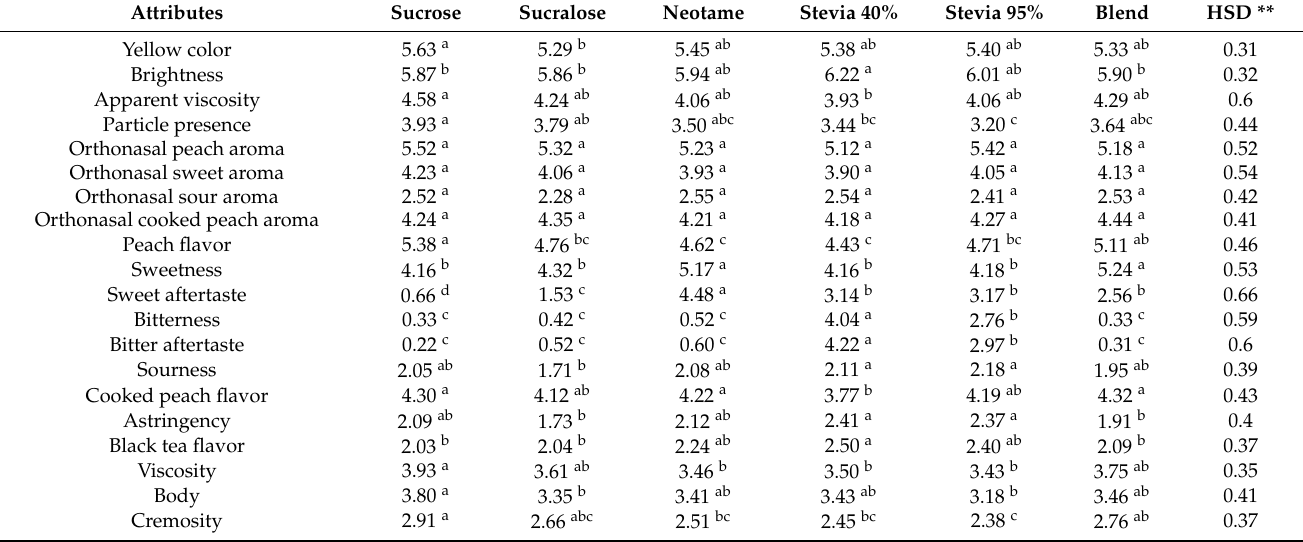
Table 3. Attributes’ means * of descriptive sensory analysis for each peach juice sample ( n =